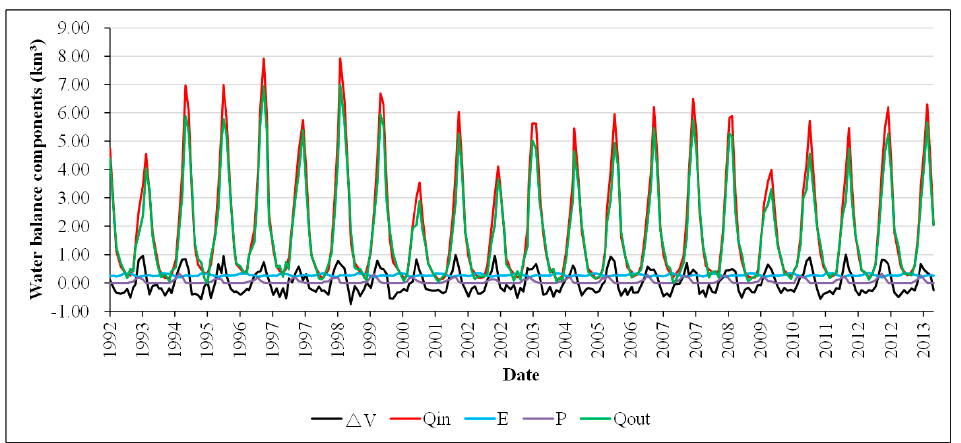
Figure 22. Variations of different water budget components of the SPLC from 1992 to 2016.